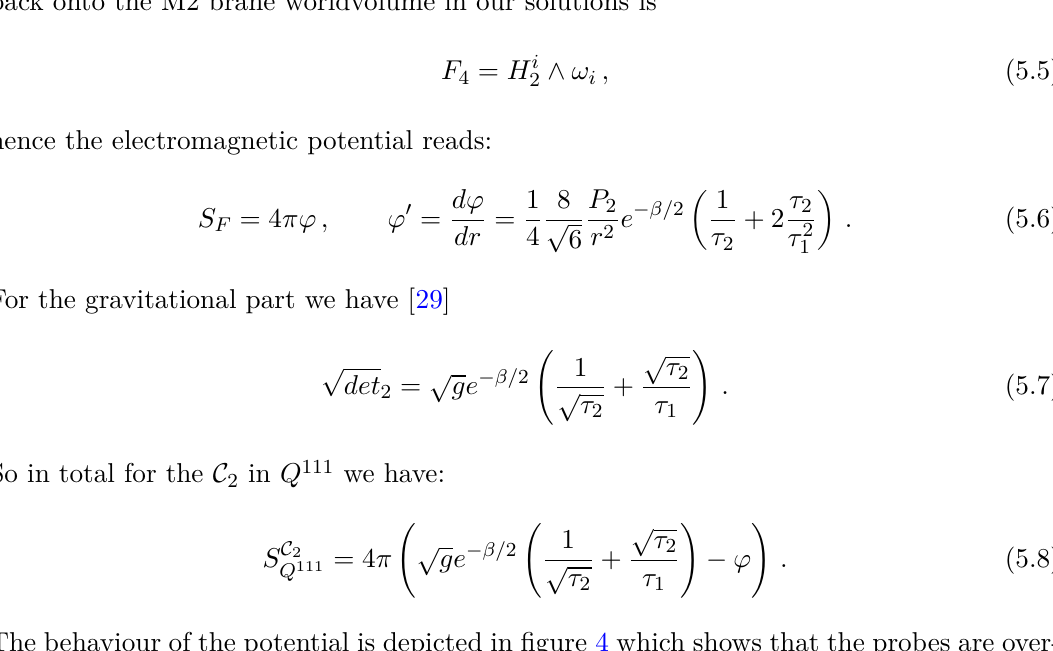
Figure 4 . Potential for M2 brane wrapped on C 2 for the spherical AdS 4 solution without R- symmetry field, for configurations with magnetic charge P and P = 8 2